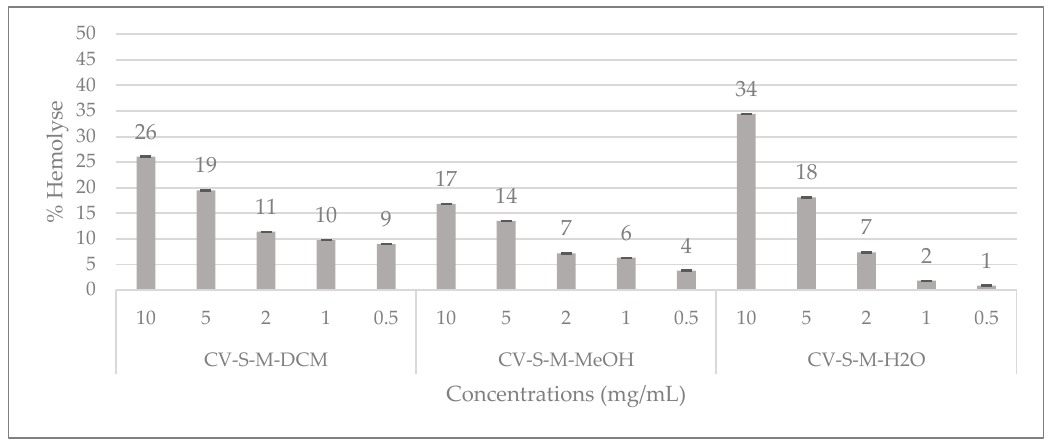
Figure 4. Hemolytic effects of C. villosa stems extracts. All values are expressed as mean of triplicate ± SD.